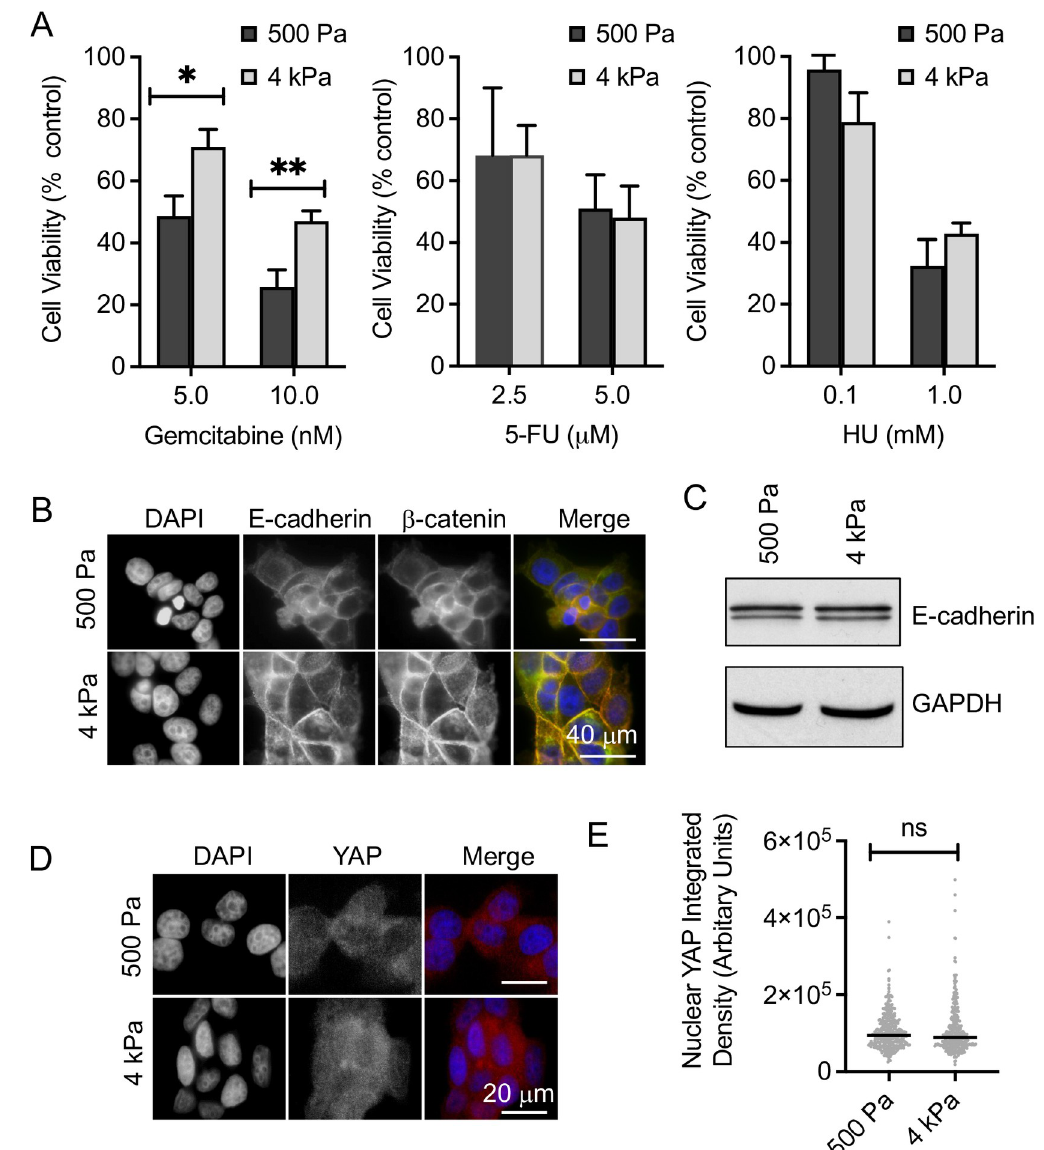
Fig 2. Matrix stiffness modulates chemotherapeutic resistance to gemcitabine but this is not attributed to classical EMT. (A) MCF-7 cells were cultured on 500 Pa and 4 kPa hydrogels for 24 hrs prior to the addition of chemotherapeutic agents as indicated; 5-fluroruracil (5-FU), hydroxyurea (HU), and gemcitabine. After 72 hrs cell viability was measured by alamarBlue assay. The means and SEMs are plotted for > 3 independent repeats. Significance was calculated using a Student’s paired t-test. (B) E-cadherin and β -catenin visualised by immunofluorescence in MCF-7 cells cultured on 500 Pa and 4 kPa stiffness hydrogels for 24 hrs. (C) Western blot for E-cadherin and a GAPDH control of whole cell extracts from MCF-7 cells cultured on 500 Pa and 4 kPa stiffness hydrogels for 72 hrs. (D) Immunofluorescent visualisation of YAP in MCF-7 cells cultured on 500 Pa and 4 kPa stiffness hydrogels for 24 hrs. (E) Nuclear YAP intensity (integrated density) measured in approximately 100 nuclei for each condition for each of 3 independent repeats. The median and individual cells from pooled data are plotted. Significance was calculated using a Mann-Whitney U-test. basal levels of γ H2AX in cells at 4 kPa compared to 500 Pa, suggesting that stiffness contributes to an increase in endogenous DNA damage. The addition of gemcitabine also led to a signifi- cant increase in the intensity of γ H2AX for cells cultured on both stiffnesses, further confirm- ing gemcitabine function. However, there was no difference in γ H2AX intensity between cells